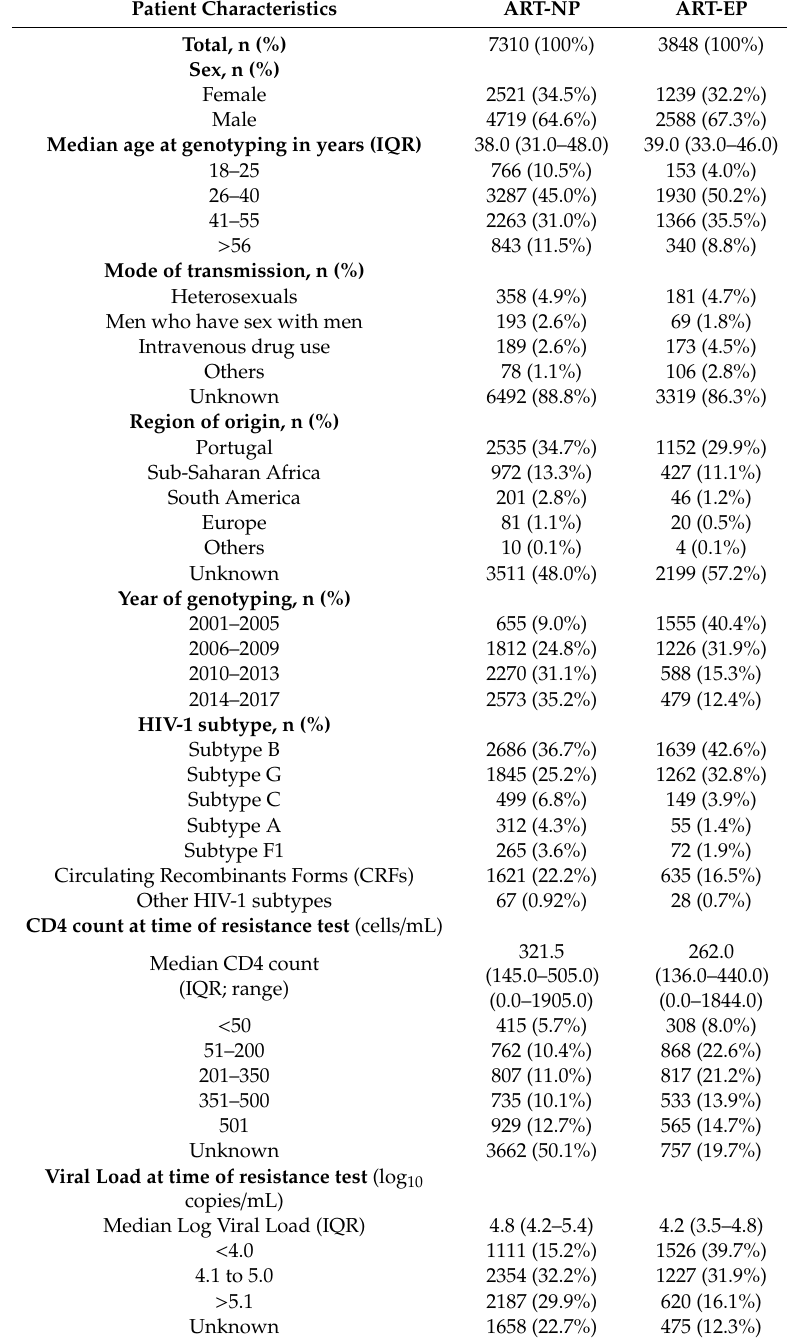
Table 1. Demographic and clinic patient characteristics, 2001–2017. ART, antiretroviral; ART-NP, antiretroviral-naïve patients; ART-EP, antiretroviral-experienced